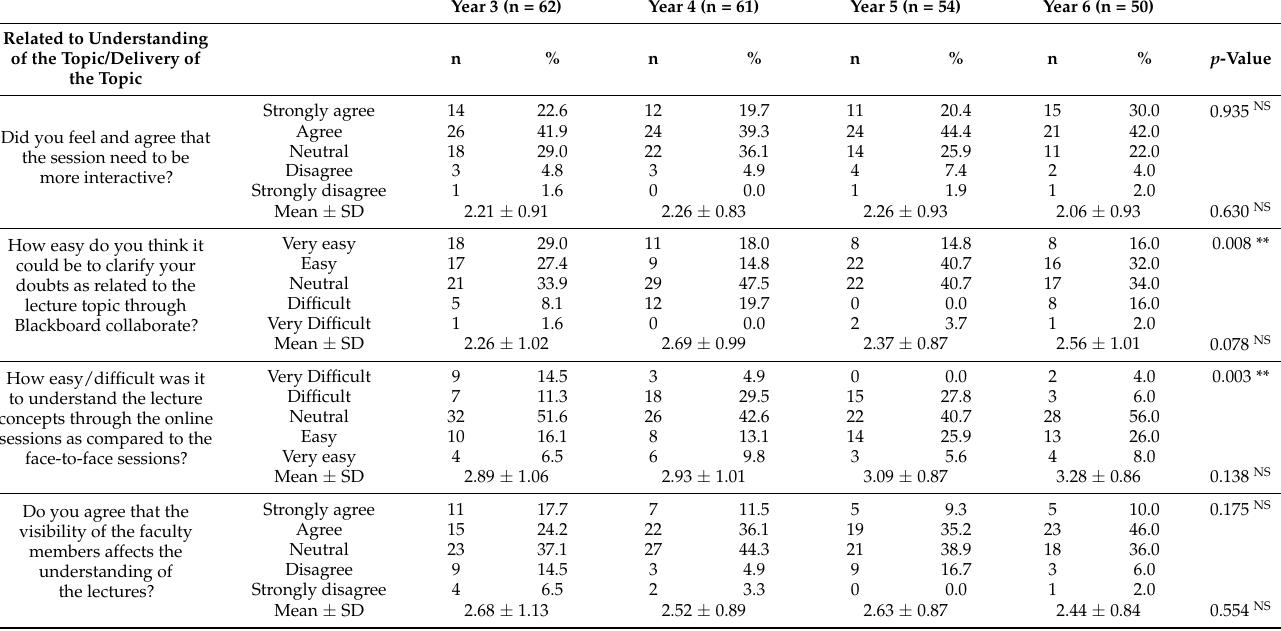
Table 6. Distribution of responses related to understanding of the topic/delivery of the topic accord- ing to level of